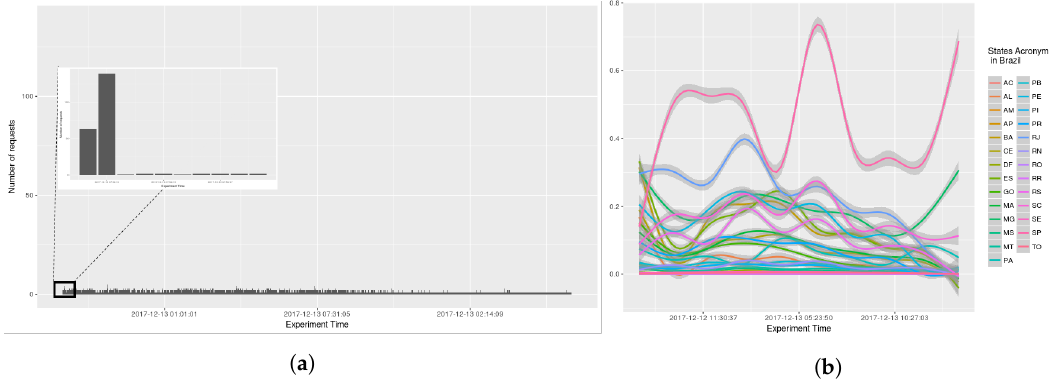
Figure 15. Scenario 02—Time Frequency. ( a ) Stations in the whole country of Brazil; ( b ) Stations grouped by states.